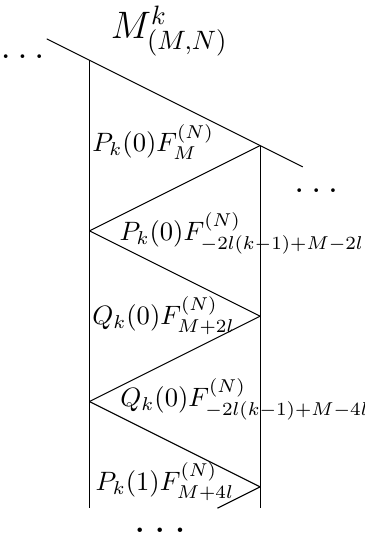
Figure 15. Graphical presentation of terms in the formula for M k term is depicted in accordance to the domain of the lattice where it appears for the first